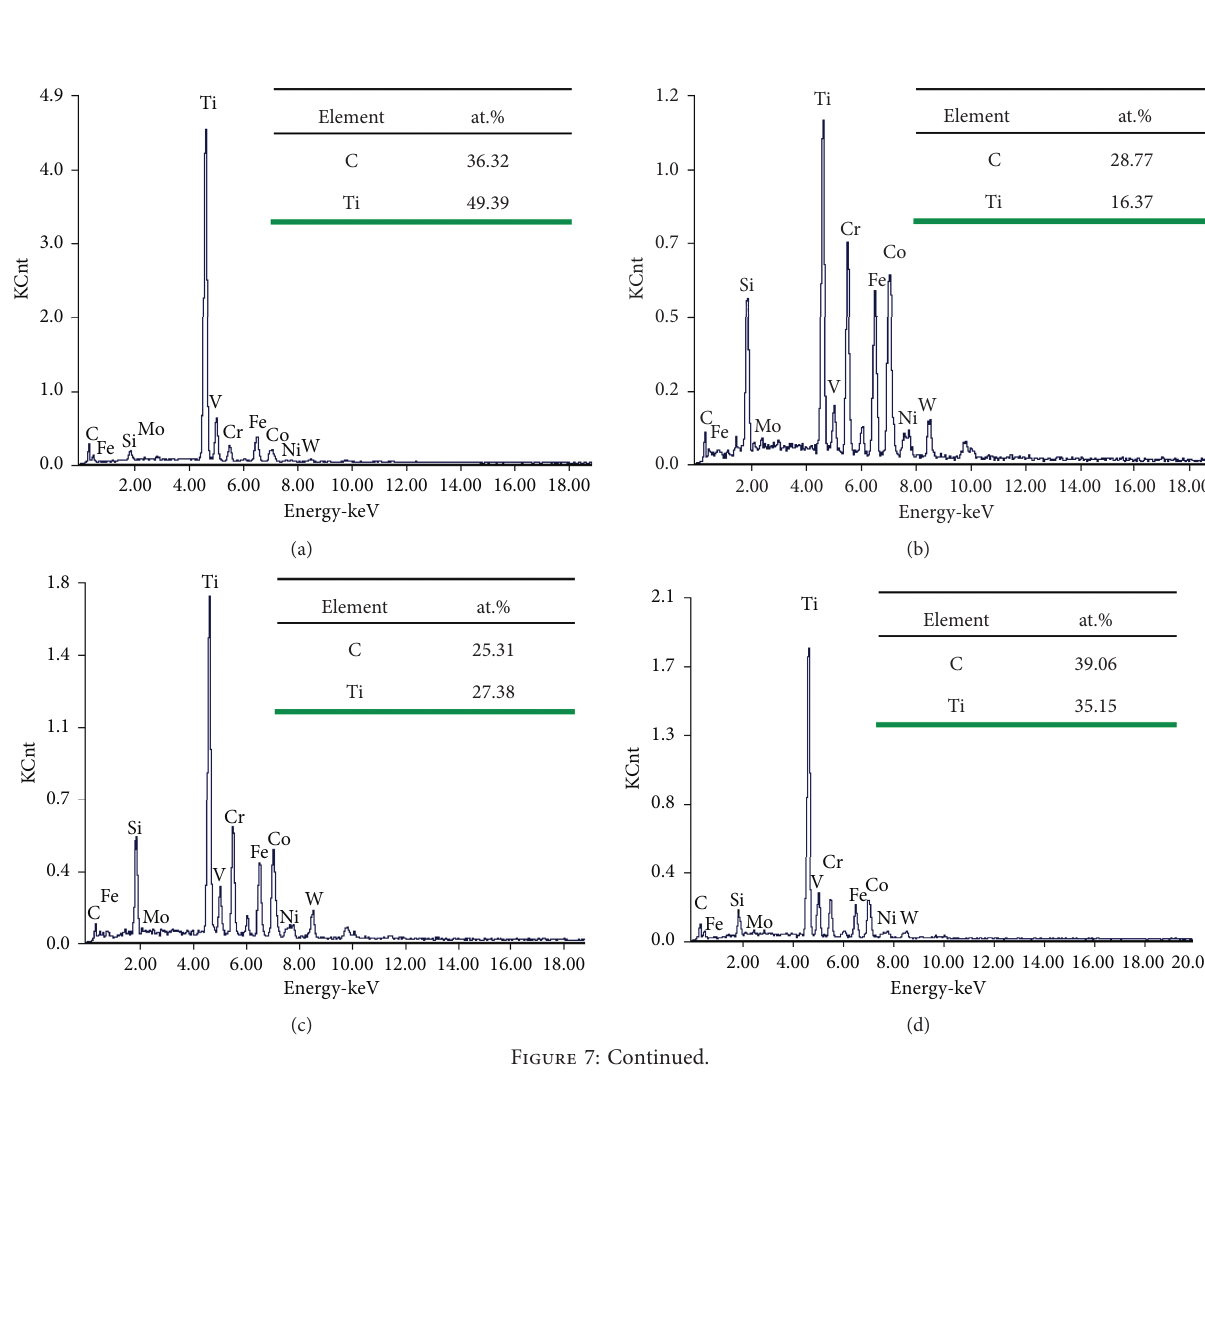
Figure 6: Model of TiC formation [5]. (a) Solid-liquid interface between Ti and C; (b) Ti and C directly reacted to form TiC diffused through the TiC x layer, reacting with the remaining C and then TiC precipitated from the solution and grew